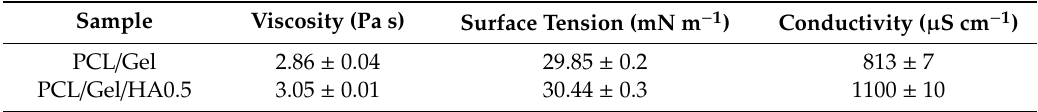
Table 1. Physical properties of the solutions used in the current